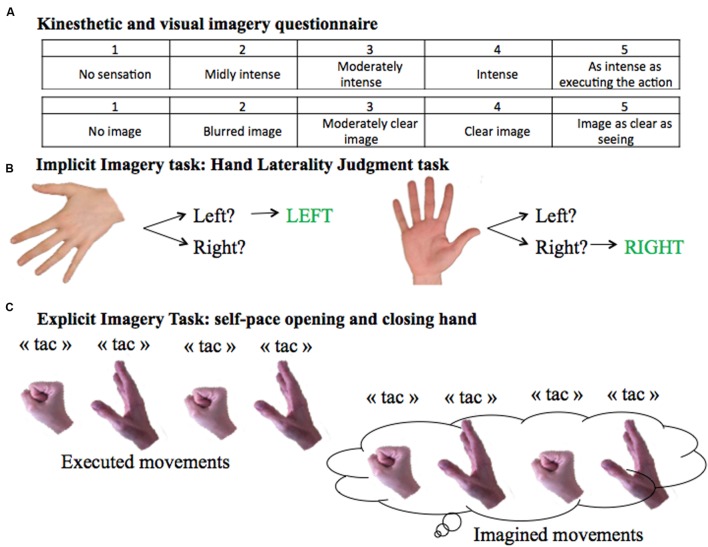
Motor Imagery Tasks. (A) KVIQ scoring system from 1 to 5 for the visual and the kinesthetic scores. (B) Implicit imagery task: Hand Laterality Judgment Task. (C) Explicit imagery task: self-pace hand opening and closing.